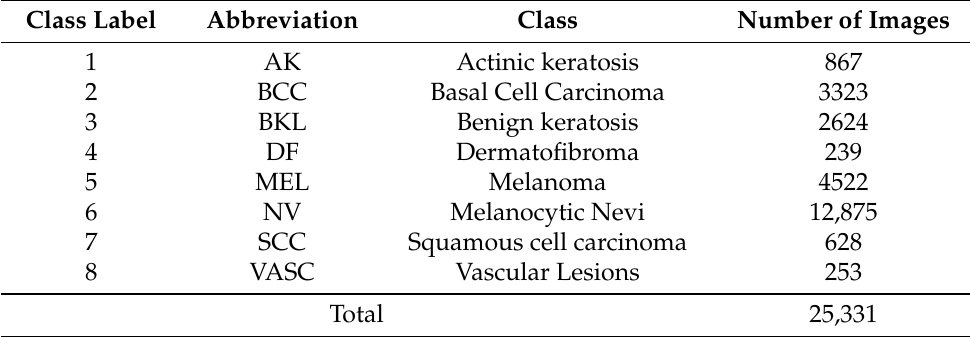
Table 1. Detail of distribution of images across different classes in ISIC 2019 training